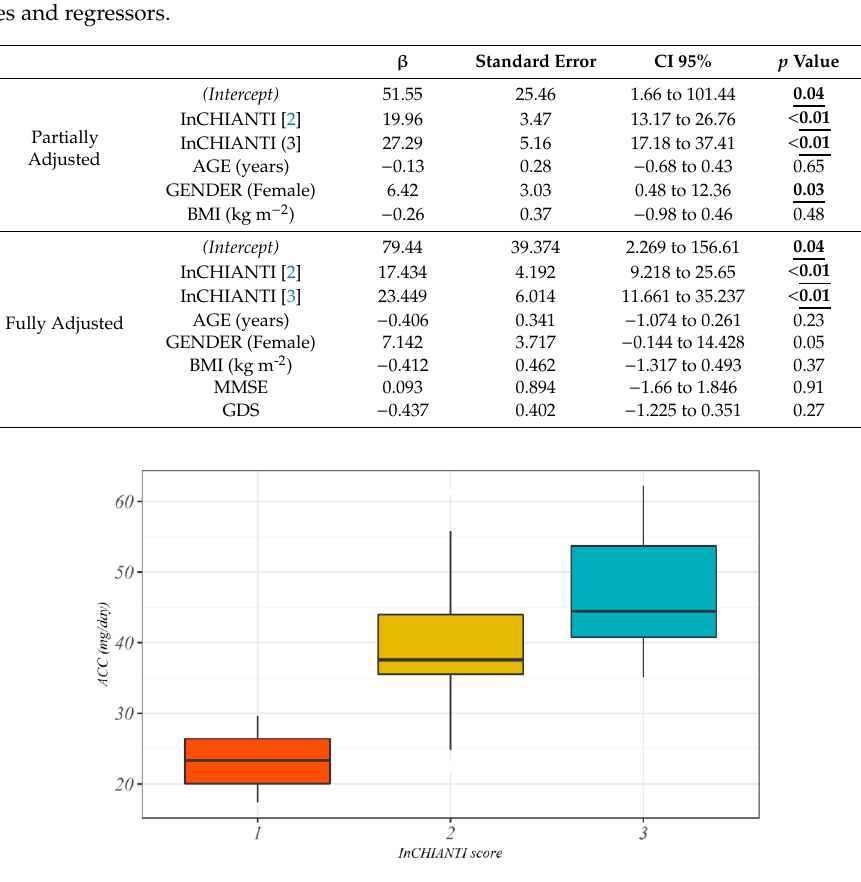
Figure 1. Box plot of mean acceleration per day estimated from actigraph for the three declared levels of PA according to the InCHIANTI questionnaire (the three groups significantly different from each other, p < 0.01).